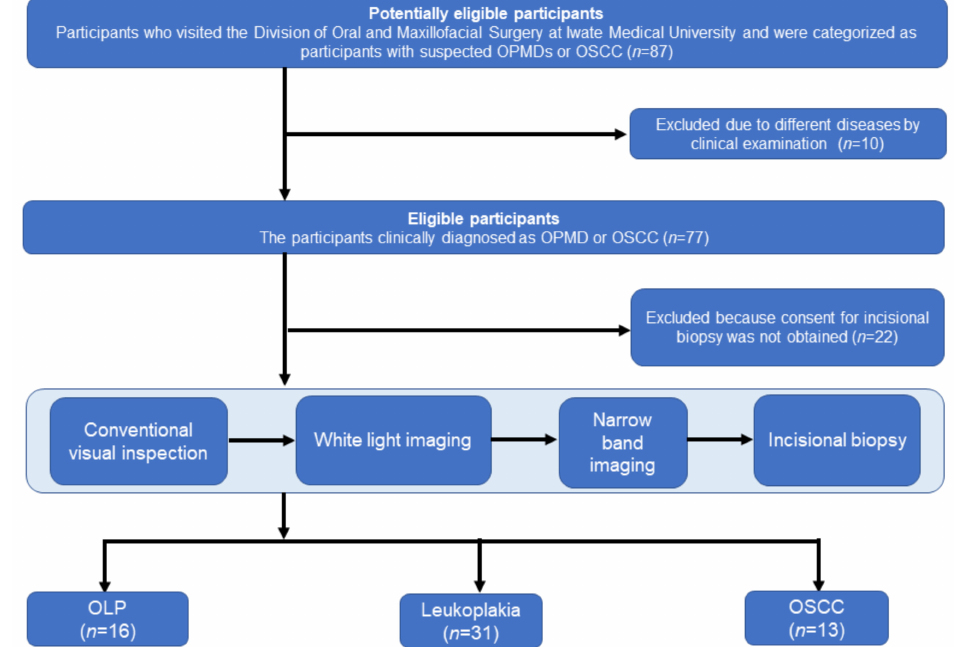
Figure 1. Flow diagram of the participants. Includes epithelial hyperplasia, oral epithelial dysplasia, and proliferative verrucous